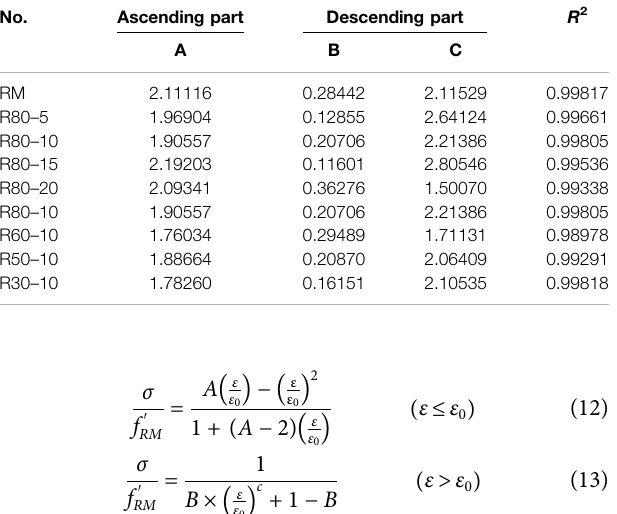
TABLE 4 | Values of parameters A, B, and C for different